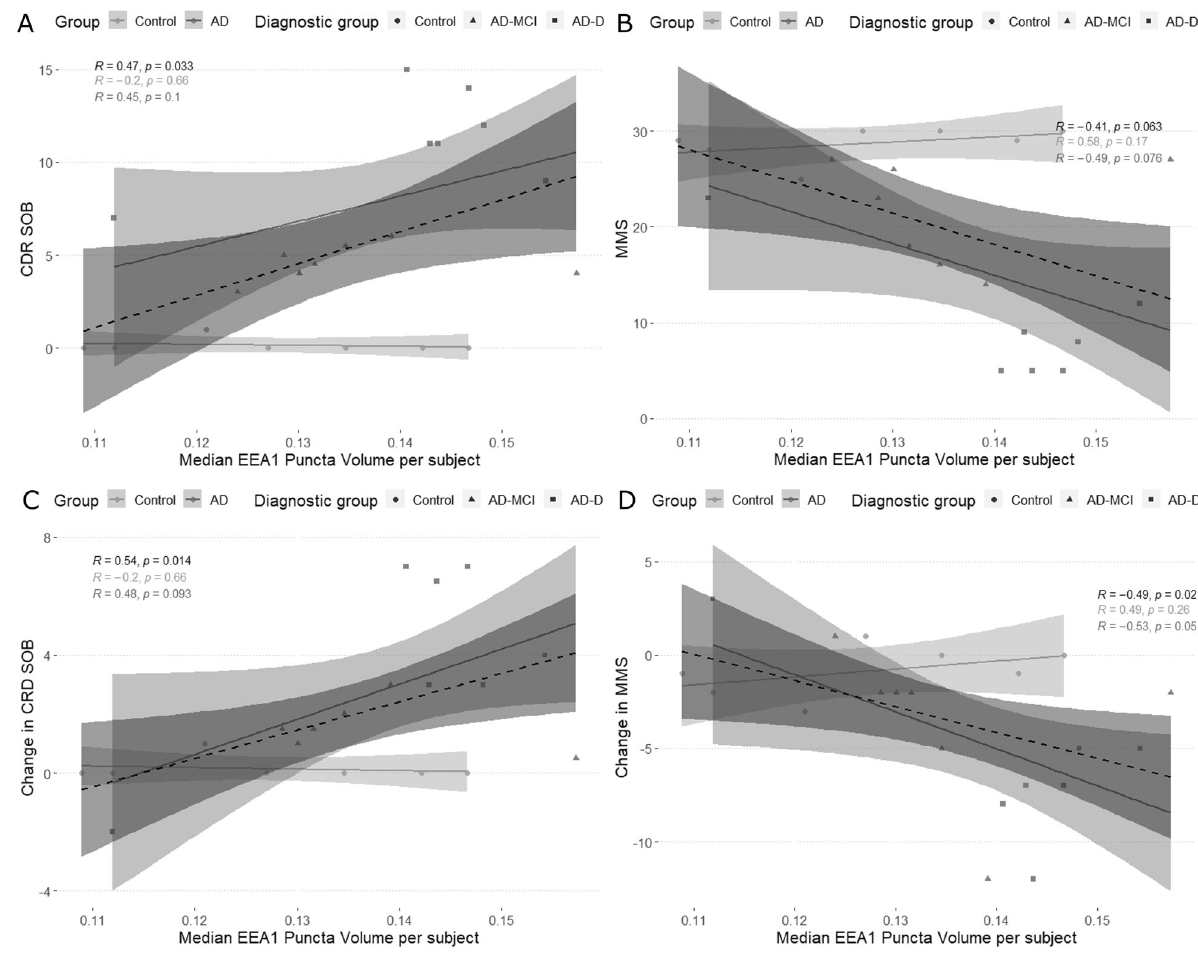
Fig. 5 Graphical representation of the correlations between cognitive measures and the median EEA1 positive puncta volume. For all cases, circles represent controls, triangles represent AD-MCI, and squares represent AD-D. Likewise, the total correlation is represented as a dashed line in dark-grey and its 95% con fi dence interval is represented in the shaded dark grey area. The partial correlations according to disease group are in grey (AD) and light grey (Control). Correlation values are on the graph, with the total correlation being in black, the correlation for controls in light grey, and the correlations for AD in dark grey. Correlations between Median EEA1 puncta volume and A CDR Sum of Boxes, B Mini Mental State, C changes in CDR Sum of Boxes, and D changes in Mini Mental